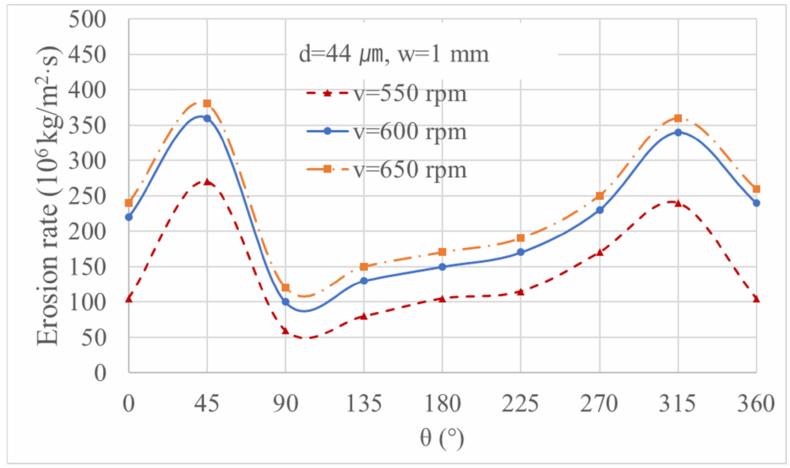
Figure 8. Erosion rate density based on the distance between the